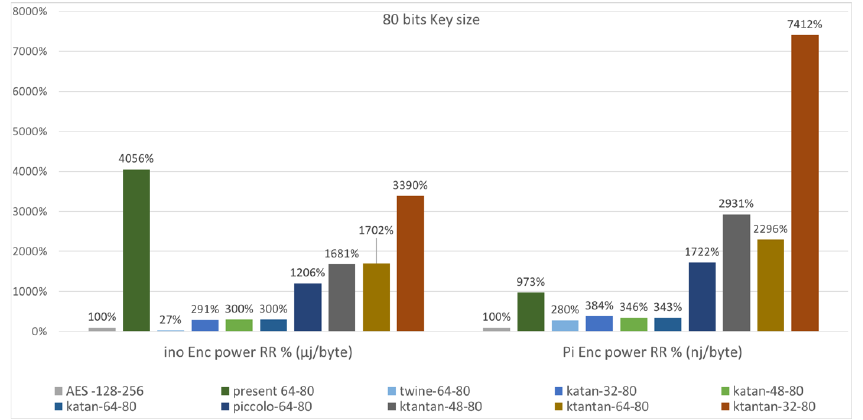
Figure 25. Group of 80-bits key size algorithms measuring ENC energy with respect to RR% in UNO versus Pi.